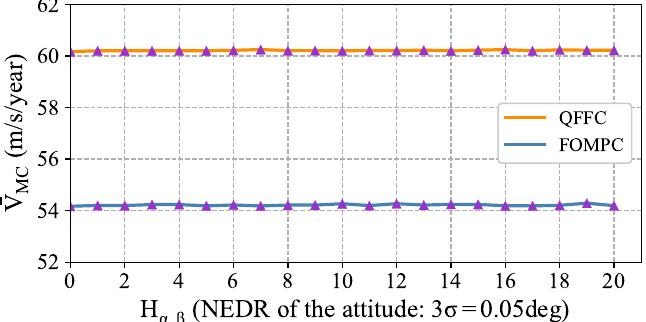
Figure 15. The results of Monte Carlo simulations for the attitude error of different magnitudes.